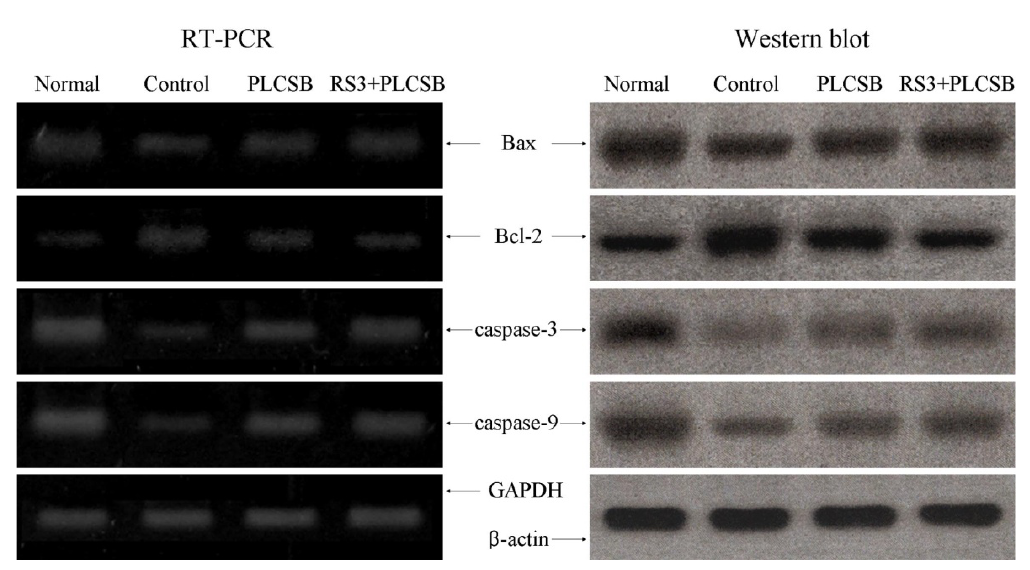
Figure 4. Effects of PLCSB and RS3 + PLCSB on mRNA and protein expression of Bax , Bcl-2 , caspase-3 and caspase-9 in AOM and DSS-induced colon cancer mice.